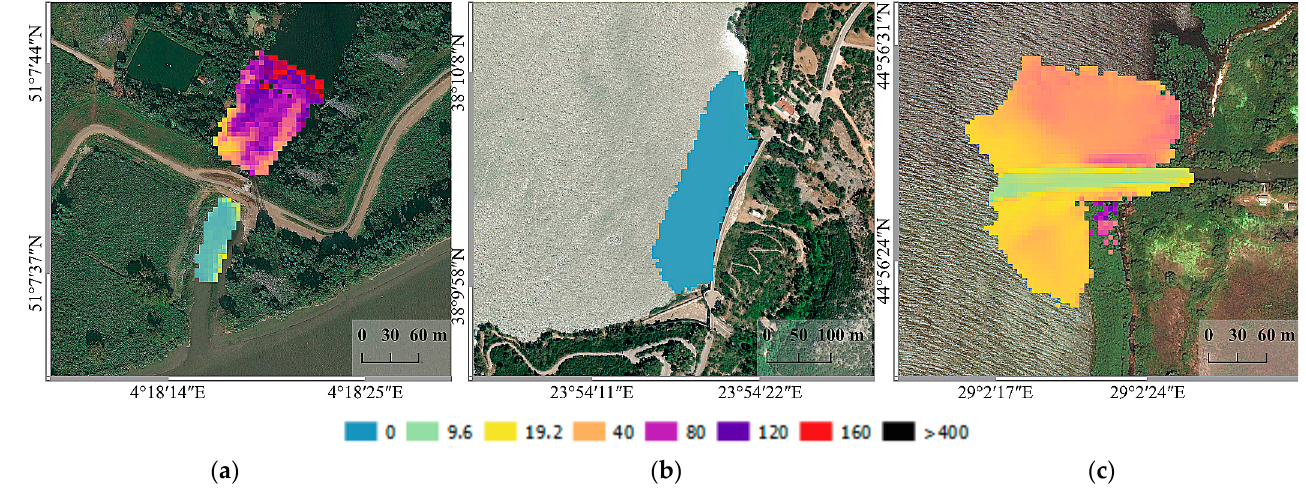
Figure 7. Examples of generated mosaicked Chl-a maps. A logarithmic colour scaling is applied with units expressed in μ g/L. ( a ) Rupelmondse Creek; ( b ) Lake Marathon; ( c ) Danube Delta.